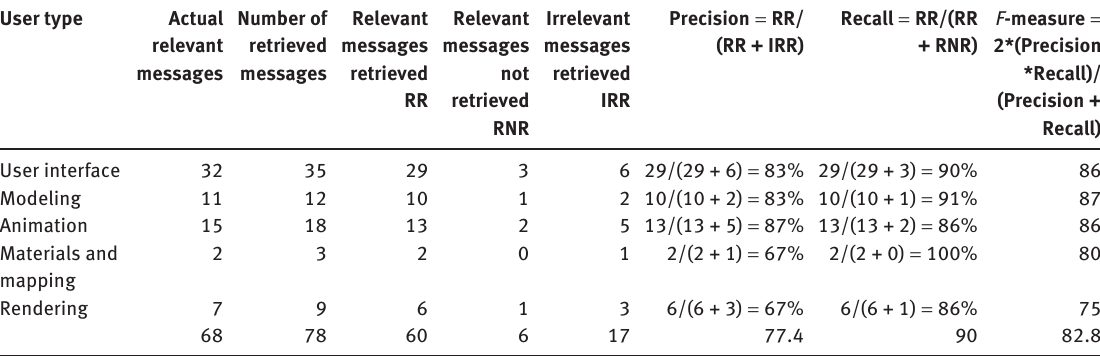
Table 3. A Summary of the